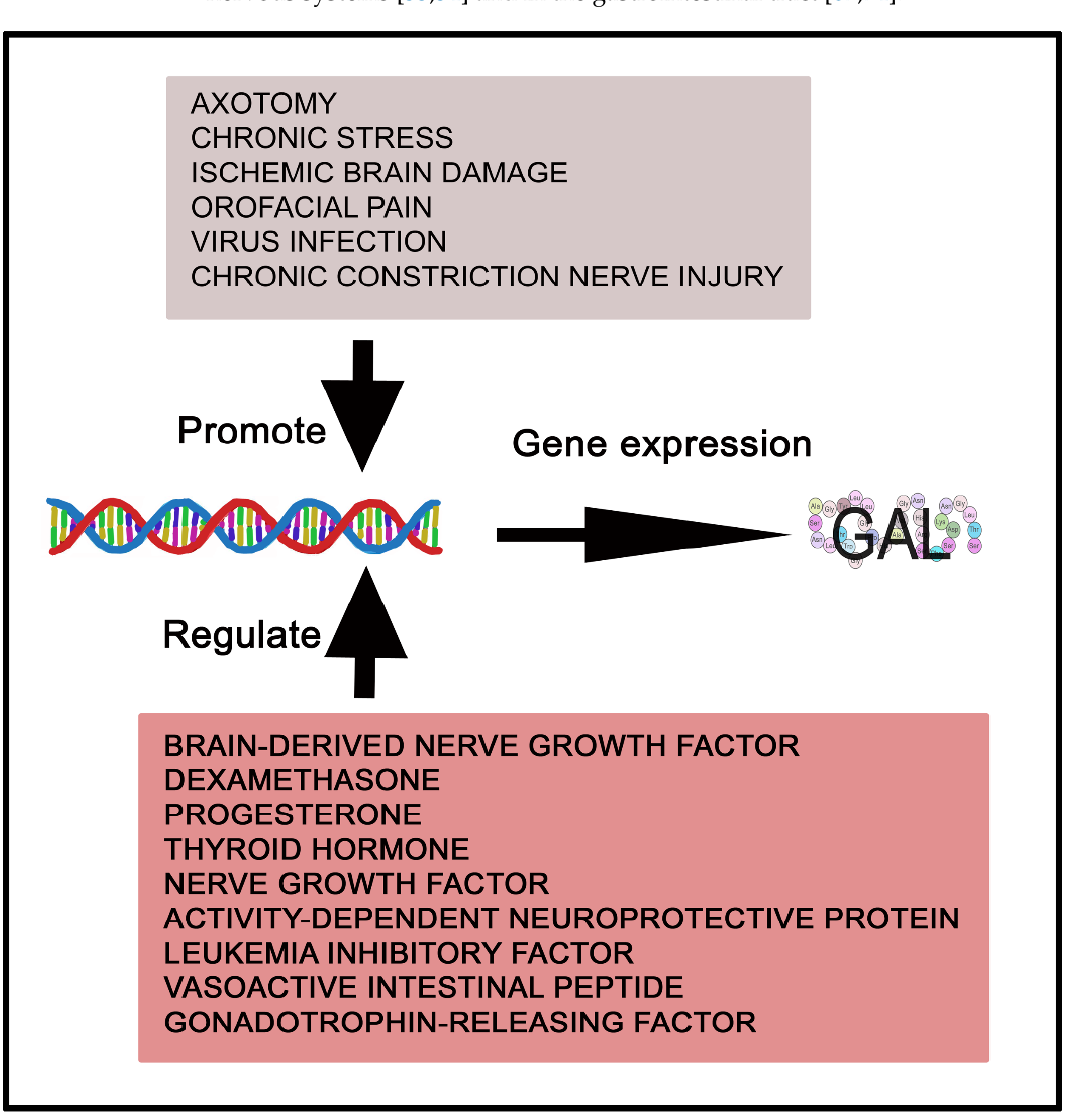
Figure 3. Pathological situations and bioactive molecules promoting and regulating, respectively, the expression of GAL.